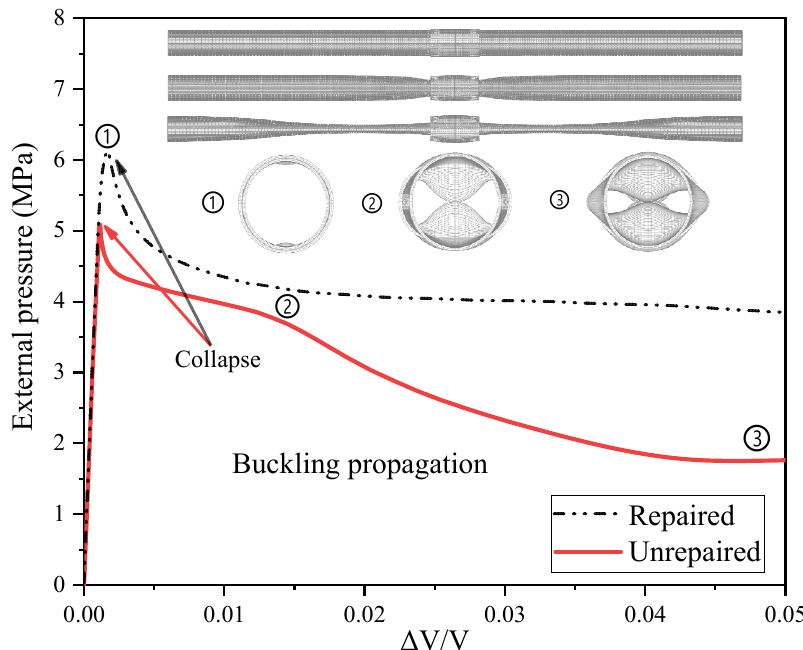
Figure 8. Diagram of external pressure and interface change in the pipeline before and after